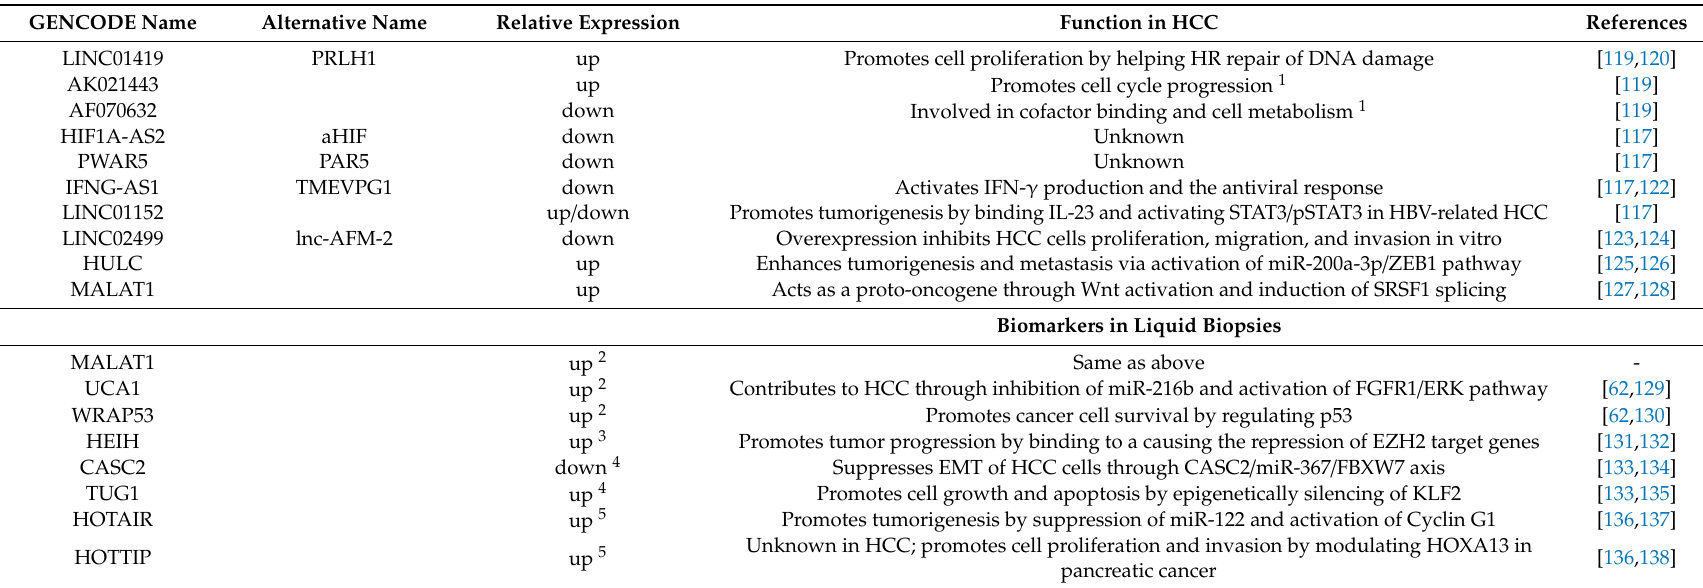
Table 2. LncRNAs deregulated in HCV-related HCC and their functions in HCC and